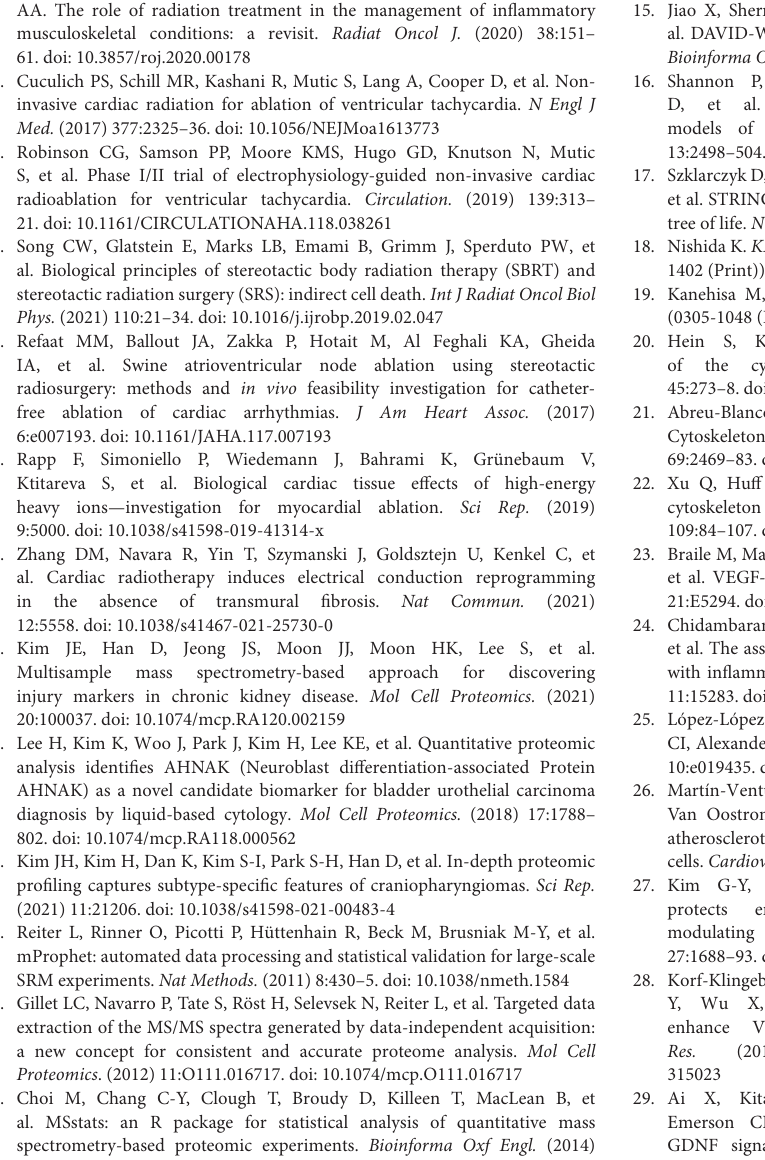
range of protein abundance of rat heart proteome. The iBAQ intensities of each sample were used with top and bottom of five abundance proteins were marked. (C) Principle-component analysis (PCA) plot comparison between radiation doses. Supplementary Figure 4 | Detailed dose group comparison scheme after LC-MS/MS analysis. The differentially expressed proteins (DEPs) after 0, 2, and 25Gy irradiation were identified after pairwise student t -test. The DEPs were calculated with fold change lower than 0.84 or greater than 1.2 with P -value lower than 0.05. Supplementary Figure 5 | Validation results of candidate proteins. (A) Cx43 (B) cTnT (C) Scn5a. Changes in expression of each protein by radiation dose and timepoint. Comparison was done with each validation